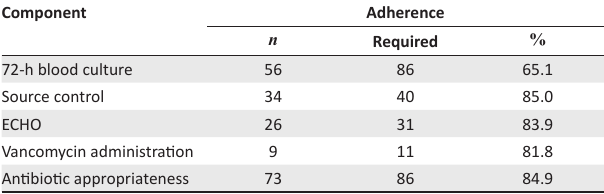
TABLE 2: Adherence to quality care